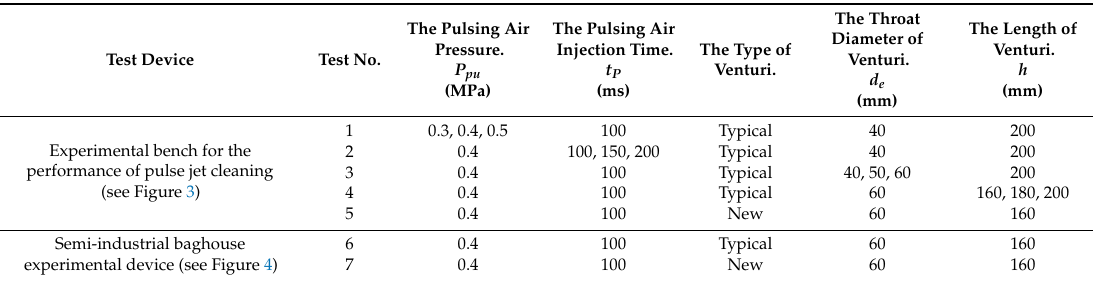
Table 1. Experimental design and